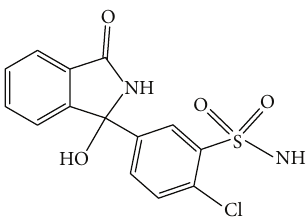
Figure 1: Chemical structure of